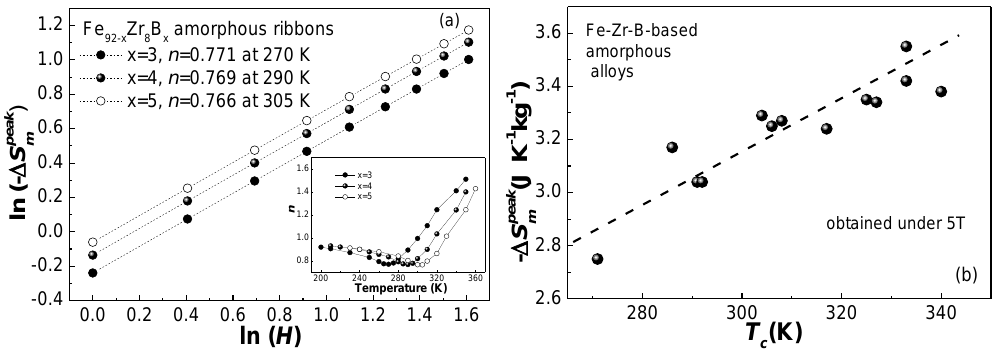
Figure 5. −Δ S m - T curves of the Fe 92-x Zr 8 B x (x = 3, 4, 5) amorphous ribbons under various magnetic fields: ( a ) x = 3, ( b ) x = 4, and ( c ) x = 5.